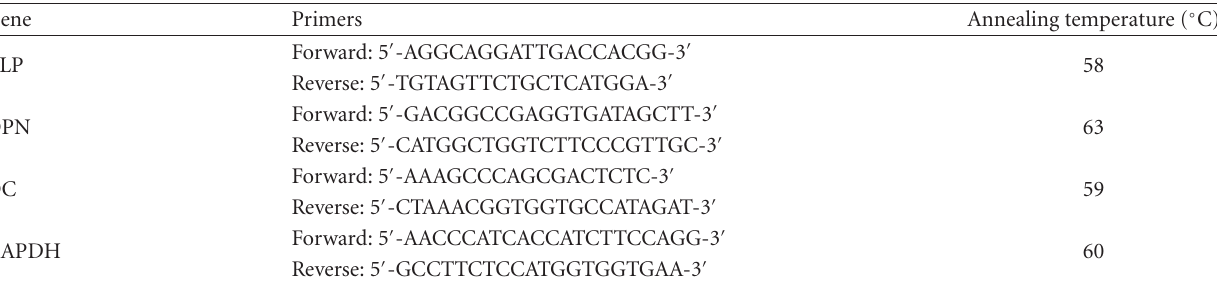
Table 1: Primers used for real-time PCR